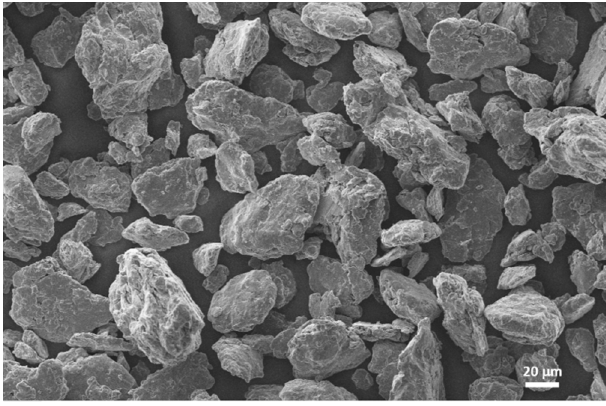
Figure 1. SEM image of the as-milled Mg–Al-based waste.